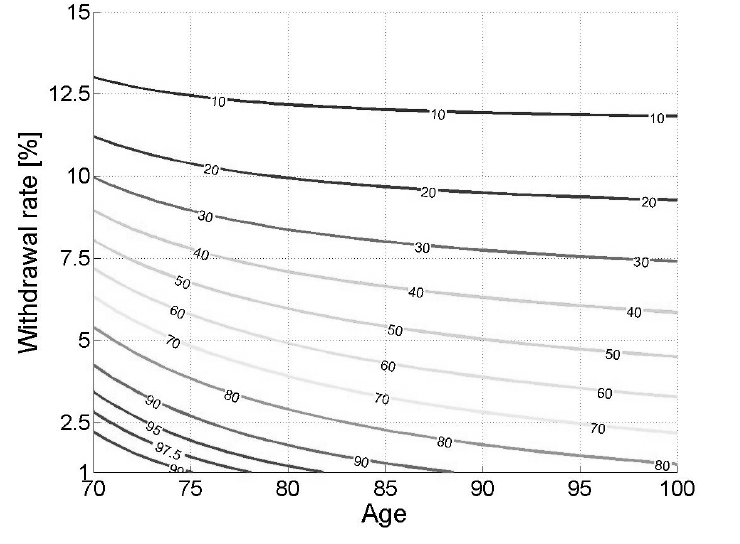
FIGURE 1: Financial survival probability for the low-risk portfolio Source: Authors